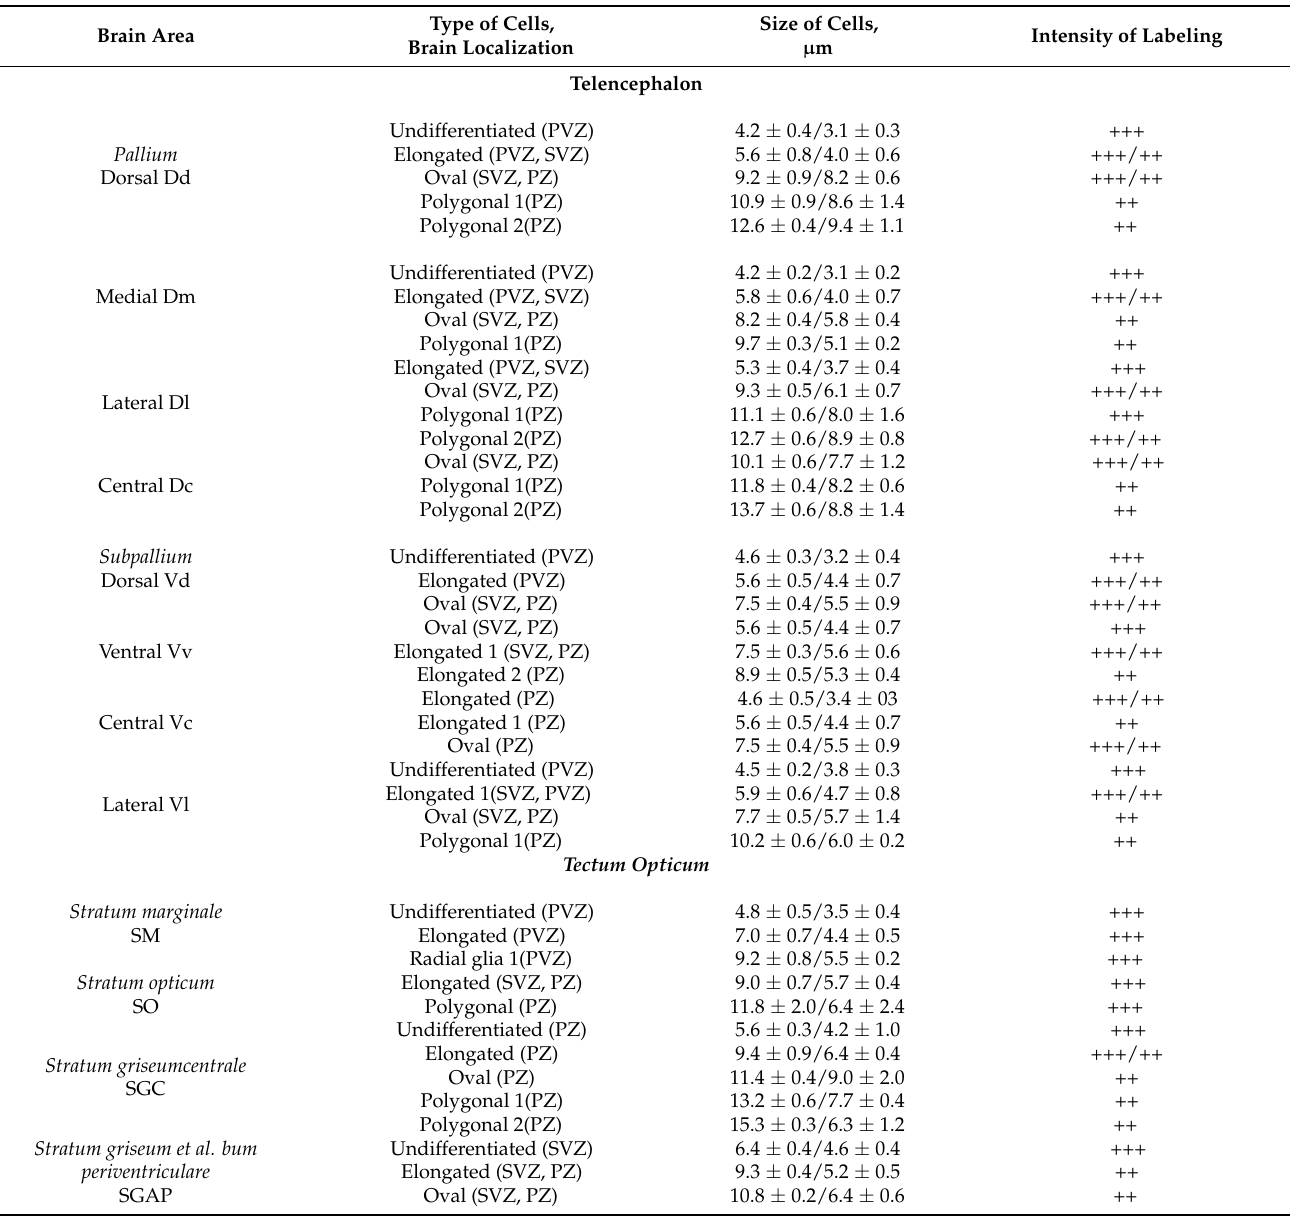
Table 2. Morphometric and densitometric parameters (M ± SD) of doublecortin-immunopositive cells in the telencephalon and optic tectum of trout, Oncorhynchus mykiss